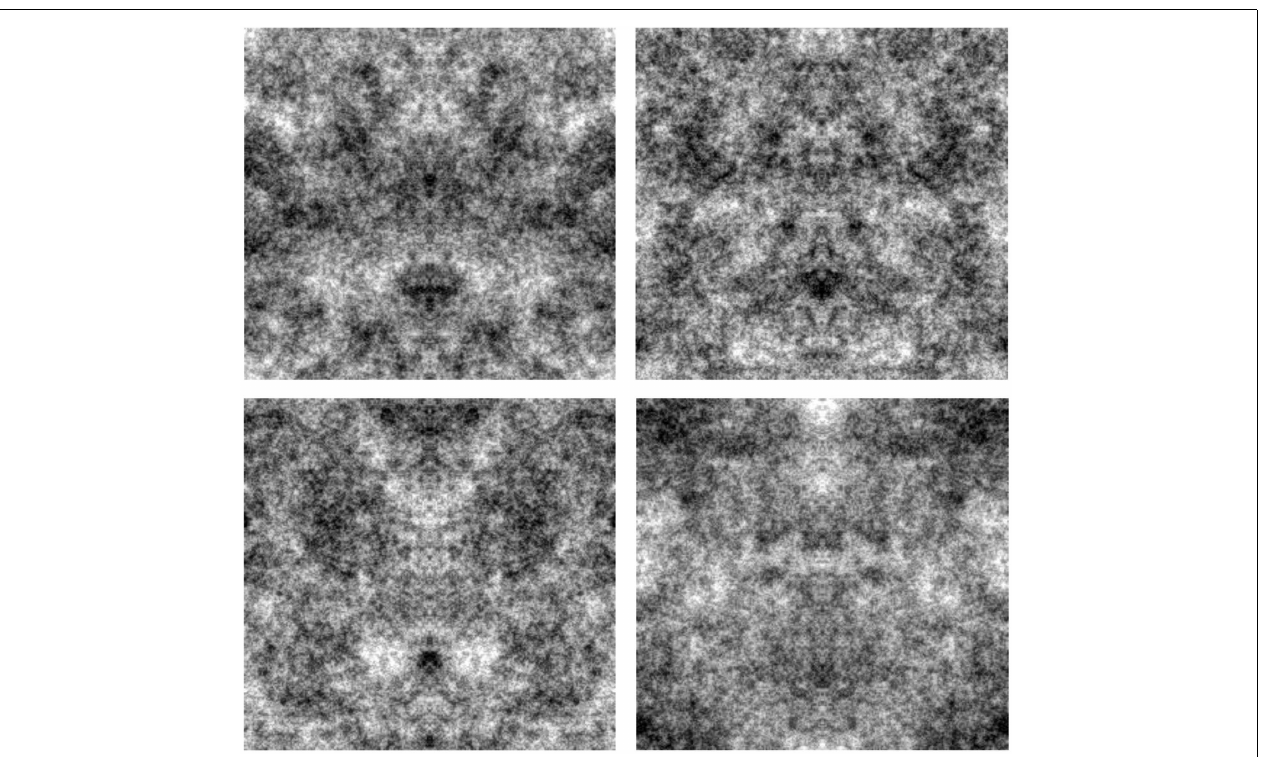
FIGURE 1 | Examples of the symmetric 1/f noise